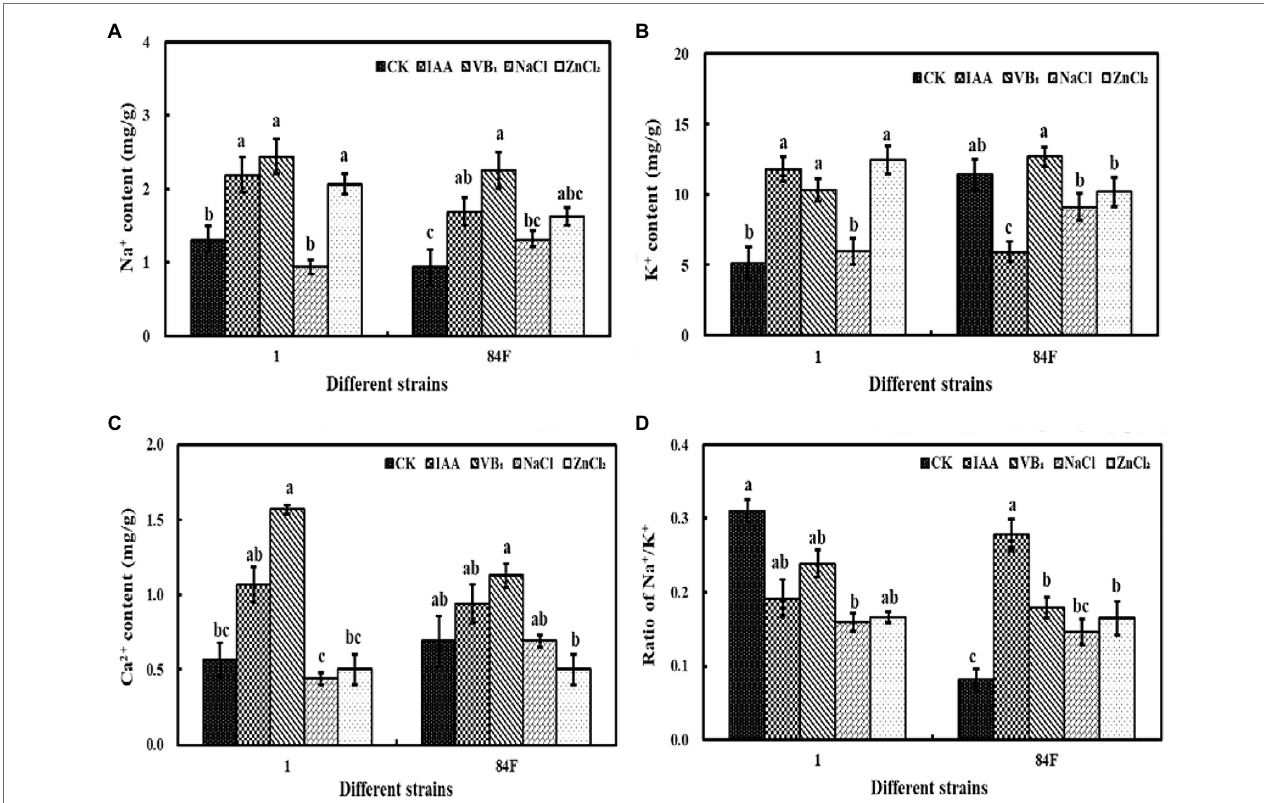
FIGURE 3 | Na + , K + , and Ca 2+ contents and ratio of Na + /K + of mycelium of E. sinensis under different treatments for 4 weeks. (A) is Na + content, (B) is K + content, (C) is Ca 2+ content, and (D) is ratio of Na + /K + . The same as Figure 1